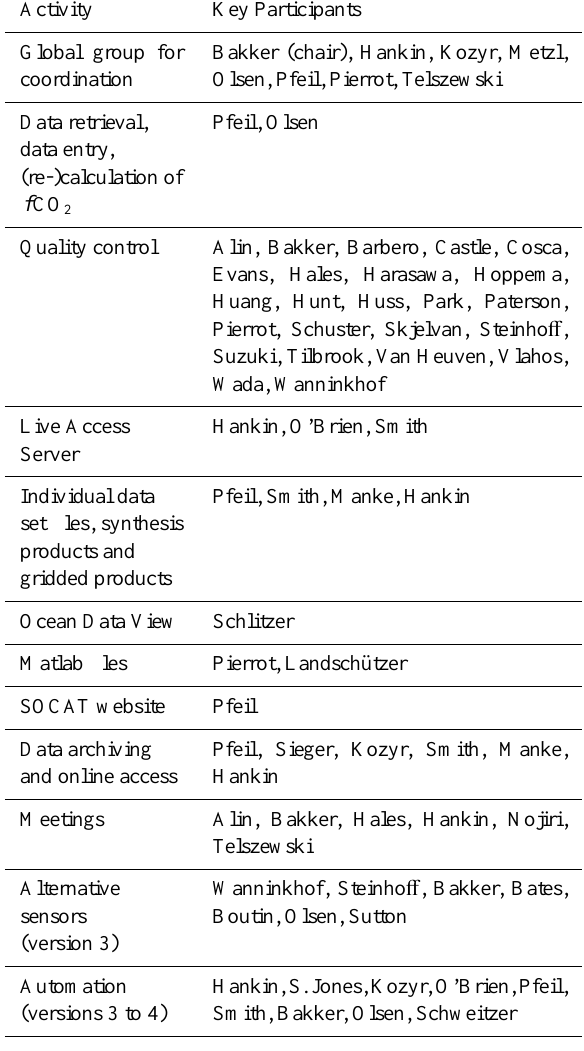
Table 4. Activities and key participants in SOCAT versions 2 and 3 to date. Regional group leads are in Table